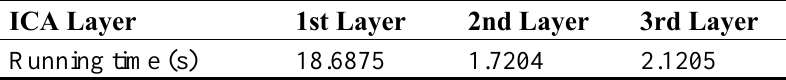
Table 2. The average test time of the underwater